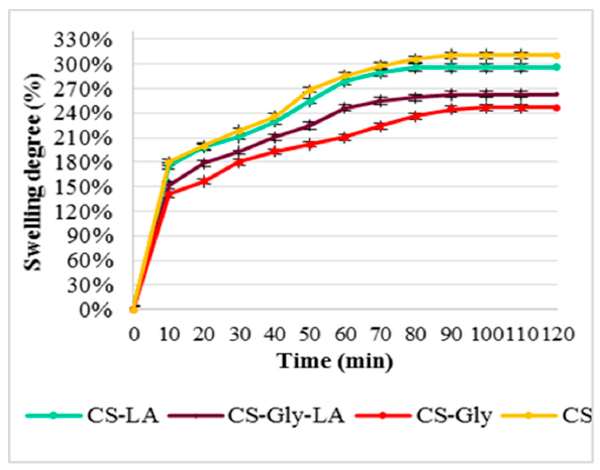
Figure 7. Swelling degree (%) in simulated gastric fluid (SGF).